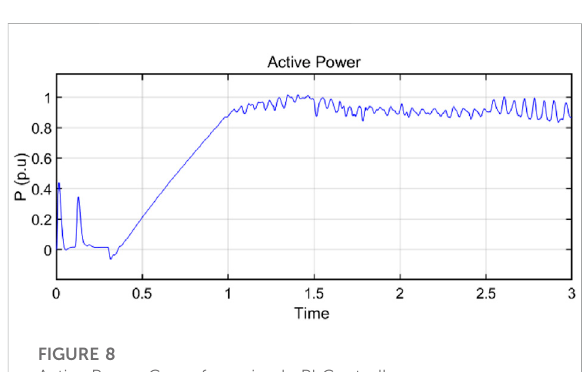
FIGURE 8 Active Power Curve for a simple PI Controller.